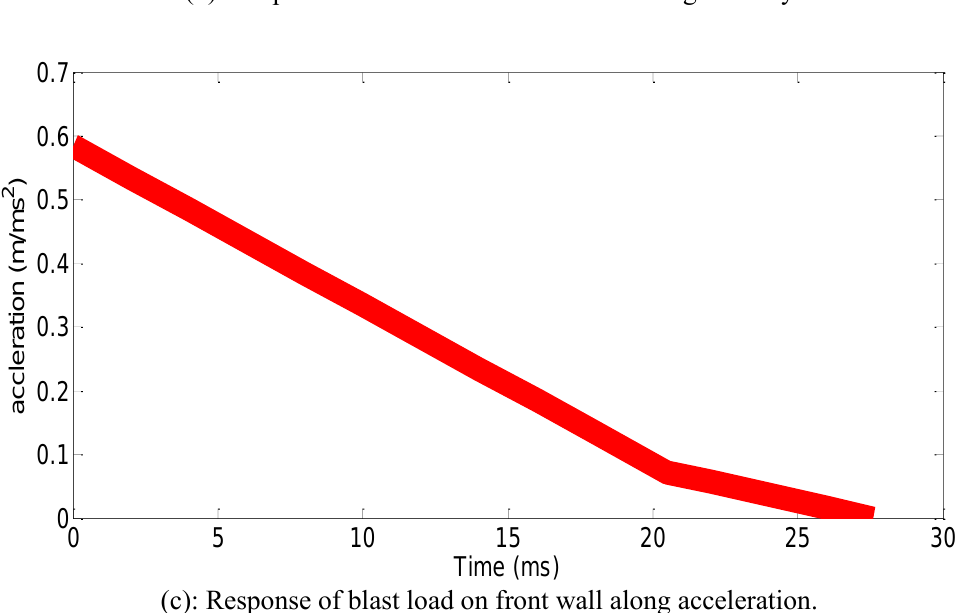
(b): Response of blast load on front wall along Velocity.